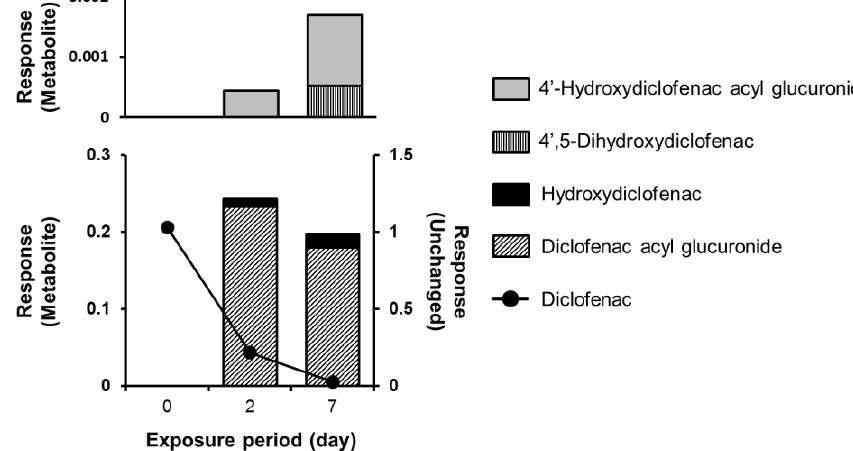
Figure 3. Time-dependent metabolism of diclofenac by PHH spheroids. The spheroids were exposed to 10 µ M diclofenac for 2 or 7 days after a spheroid formation period of 2 days. Closed circles represent unchanged diclofenac. The metabolites were identified by comparing the retention times and molecular weights with those of the standard compounds. The quantity of metabolites was determined as the relative ratio to the ion peak area of an internal standard. The experiment was performed in duplicate.